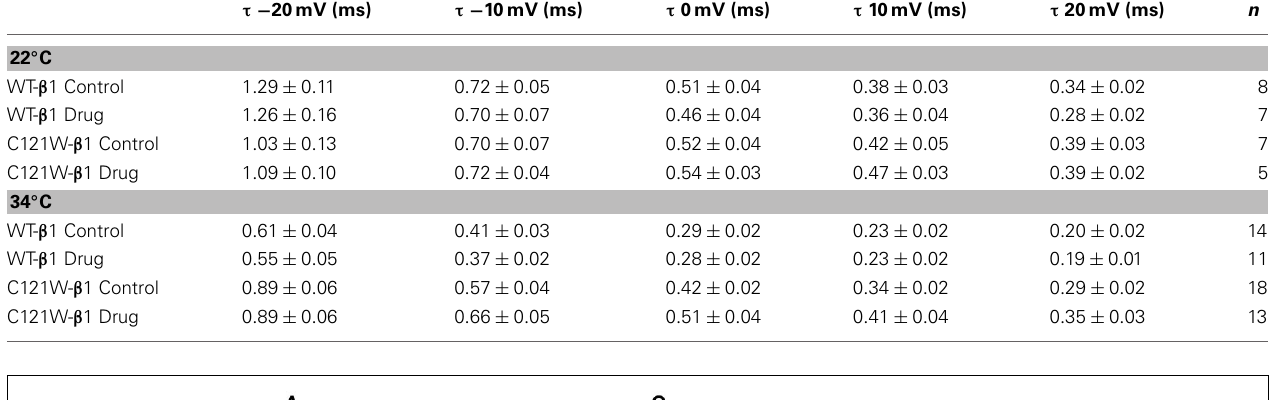
Table 2 | Open-state fast inactivation.